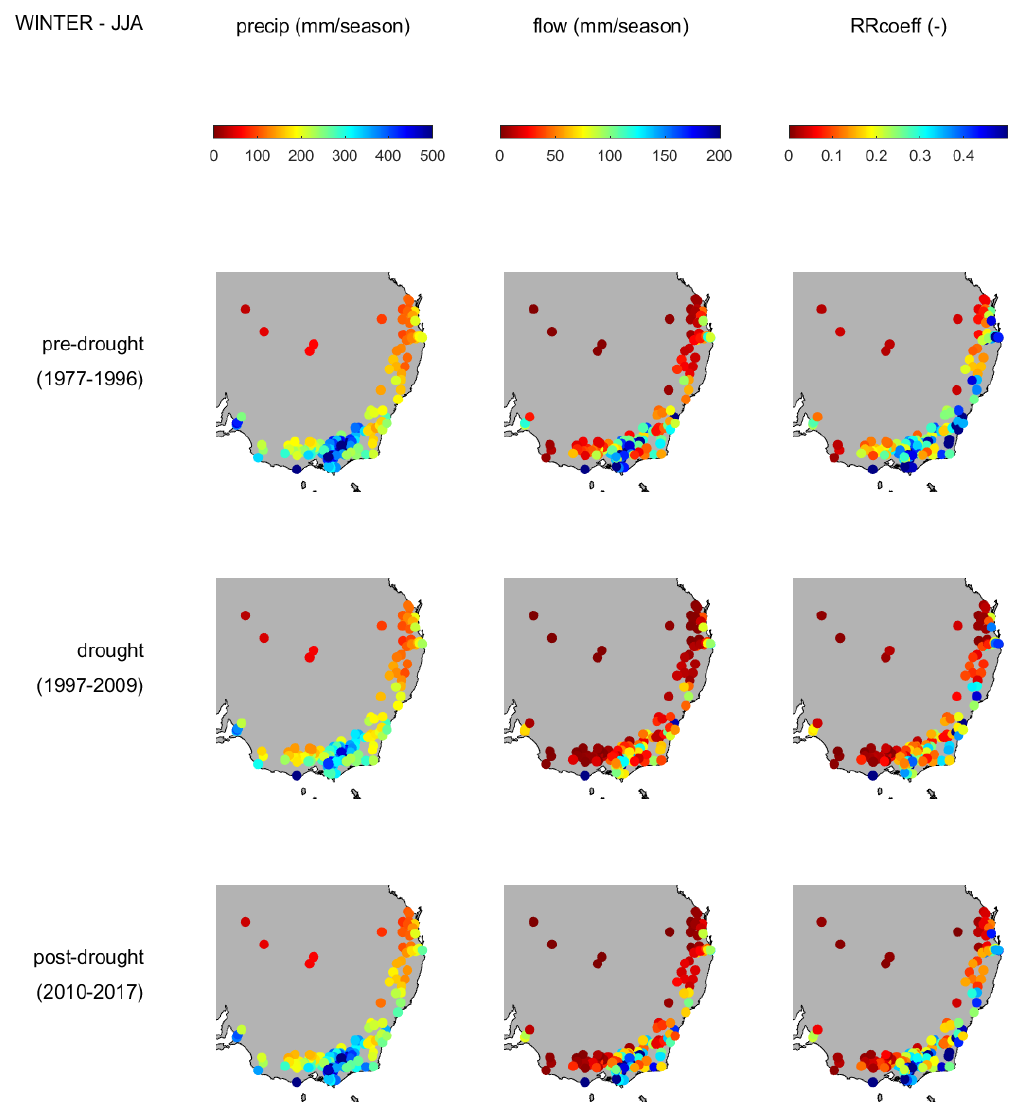
Figure B4. Same as Fig. B2 but for winter (June, July, and